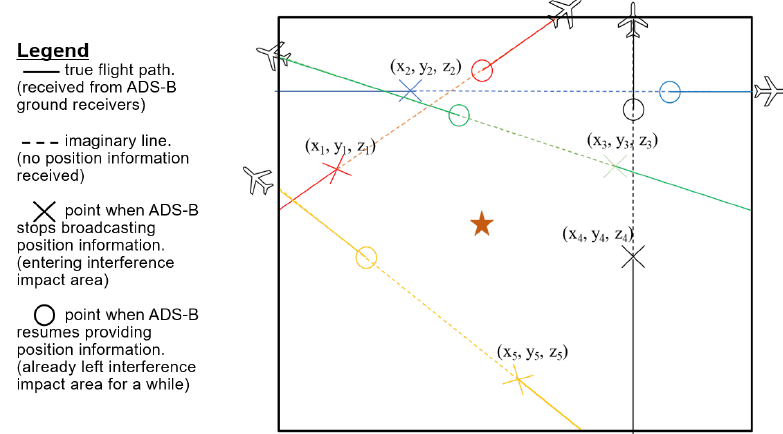
Figure 3. Top view of an airspace under impact of interference event.